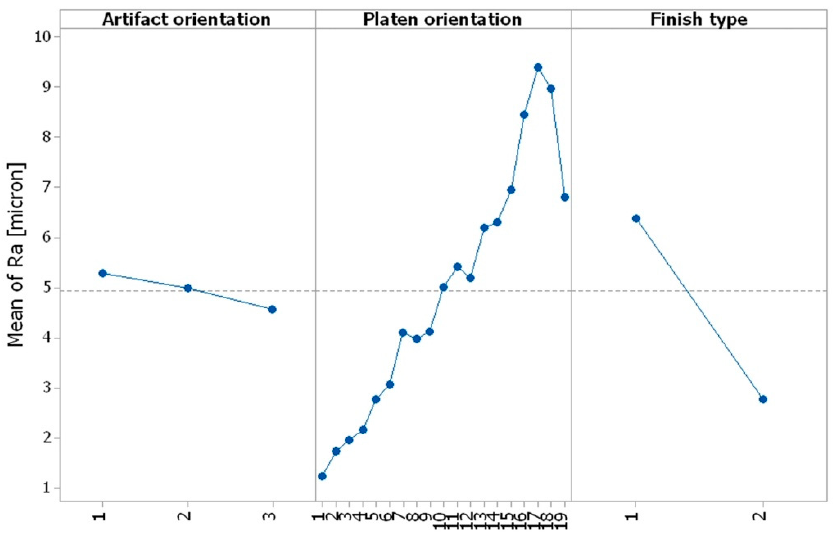
Figure 15. Main effects plot for surface roughness Ra.